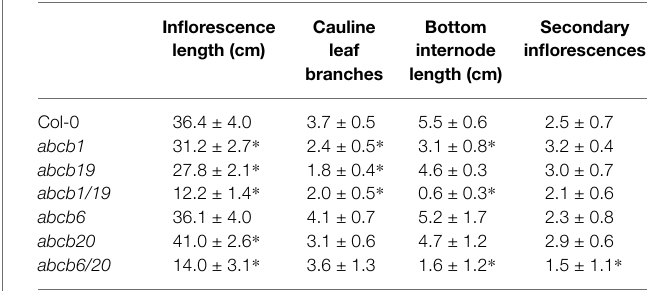
TABLE 1 | Inflorescence measurements of abcb1 , 19 , 6 , and 20 single and double mutants.